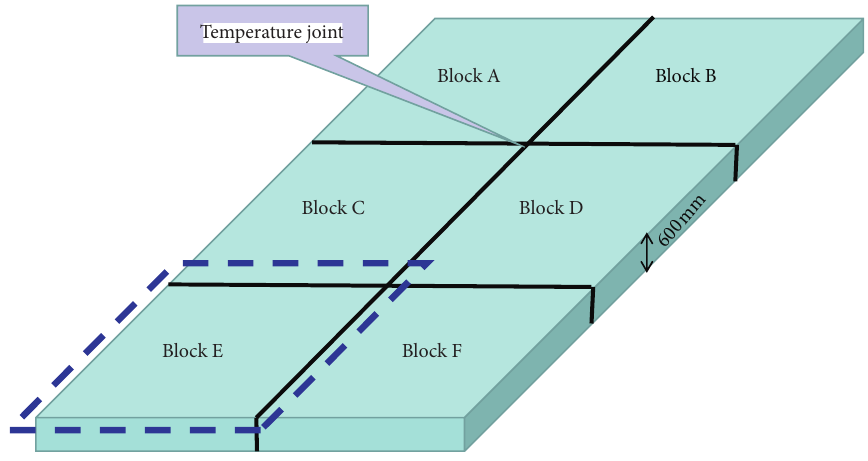
Figure 4: A base slab of the biochemical pond. Table 1: The characteristic value of the bearing capacity of the subsoil and compression